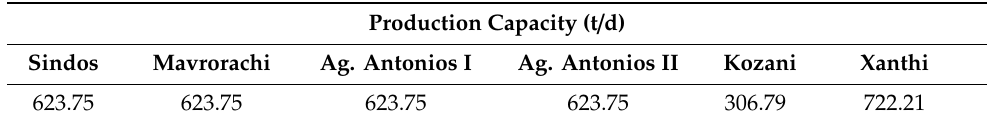
Table 6. Mortar production capacities for six ZWMP plants.